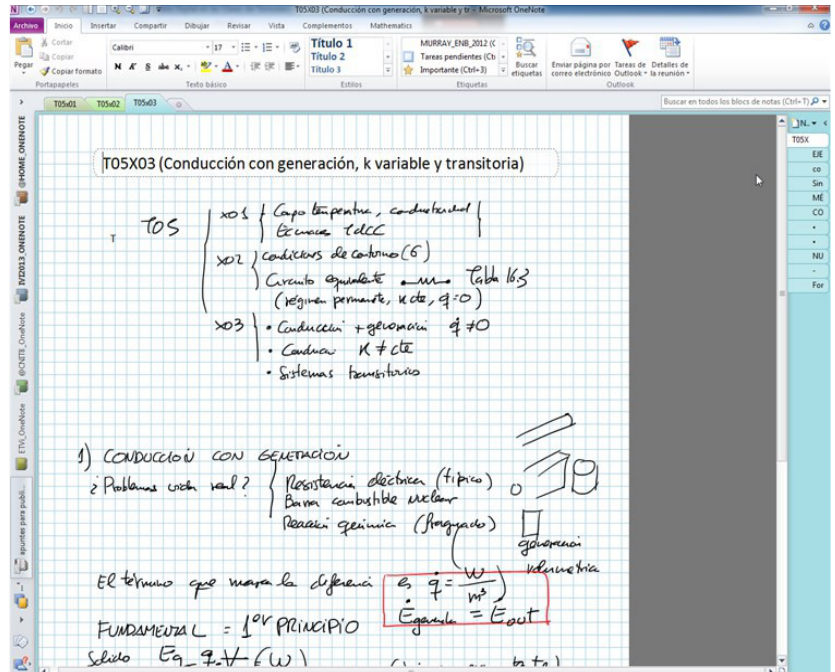
Figure 3. Microsoft OneNote screenshot. Note the tabs around the workspace that allow users to organize documents